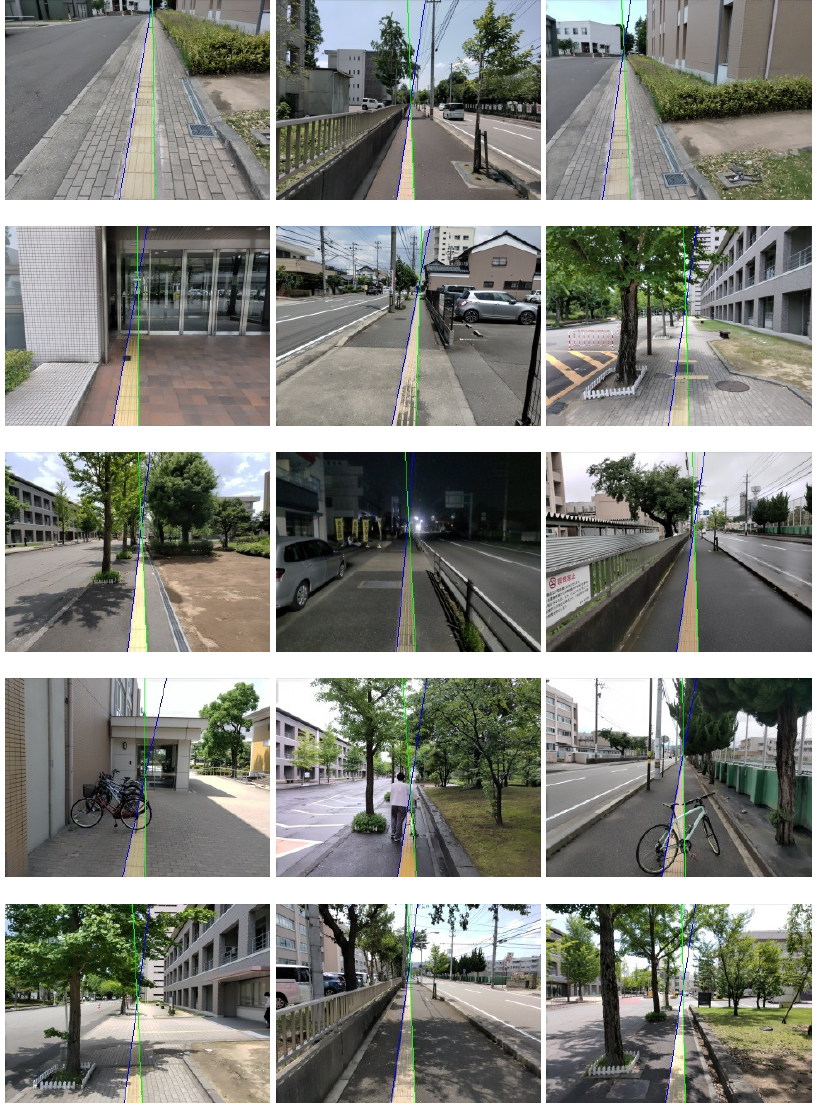
Figure 7. Category-wise qualitative results. A line pair consists of a blue line ( left ) and a green line ( right ). Categories from the top row to the bottom row: change of view angle, deficiency, illumination change, obstacle and